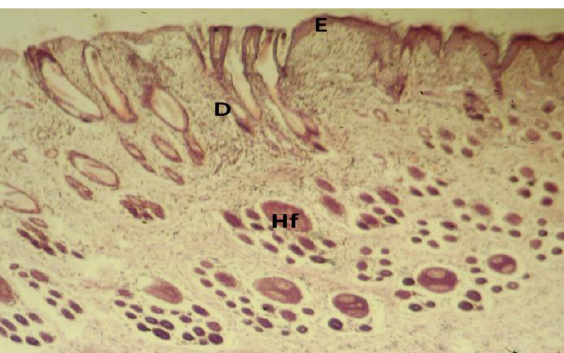
Figure, 15: Section of skin (21 days - control) shows epidermis (E) and dermis (D). H and E, 40 x.